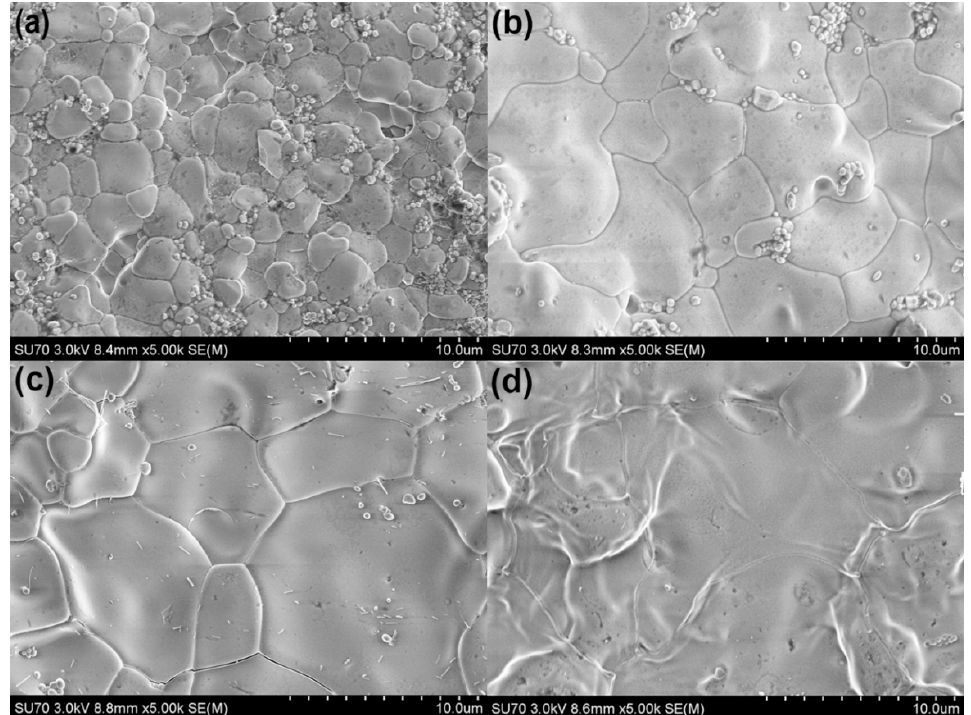
Figure 3. Scanning electron microscope images of 2Bi-8YSZ at various temperatures: ( a ) 1100 °C;